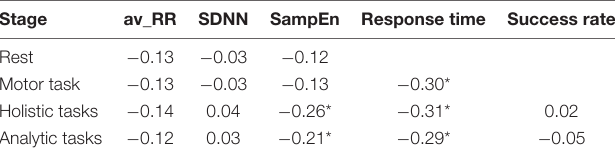
TABLE 1 | Spearman’s rank correlation coefficients for relationships between behavioral metrics (response time (ms), success rate), HRV indexes (av-RR, SDNN and SampEn) at different stages of the experiment and subjects AHS scores (* p <